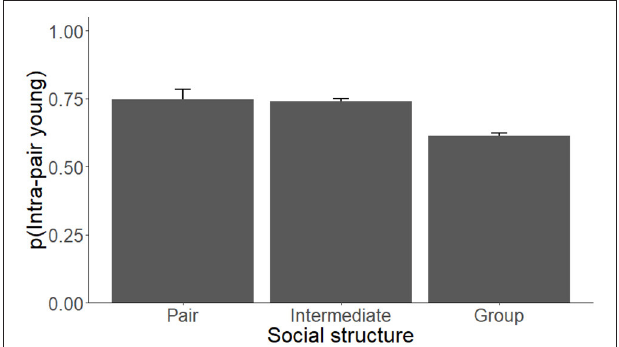
FIGURE 2 | The proportion of intra-pair young (IPY) produced by species of socially monogamous mammals that live primarily in pairs, groups, or that are intermediate between these two types of social structure. The proportions presented are based on the coefficients from the top model for IPY ( Tables 2 , 3 ) and control for phylogenetic relatedness, differences in the level of paternal care, and are weighted by sample size.